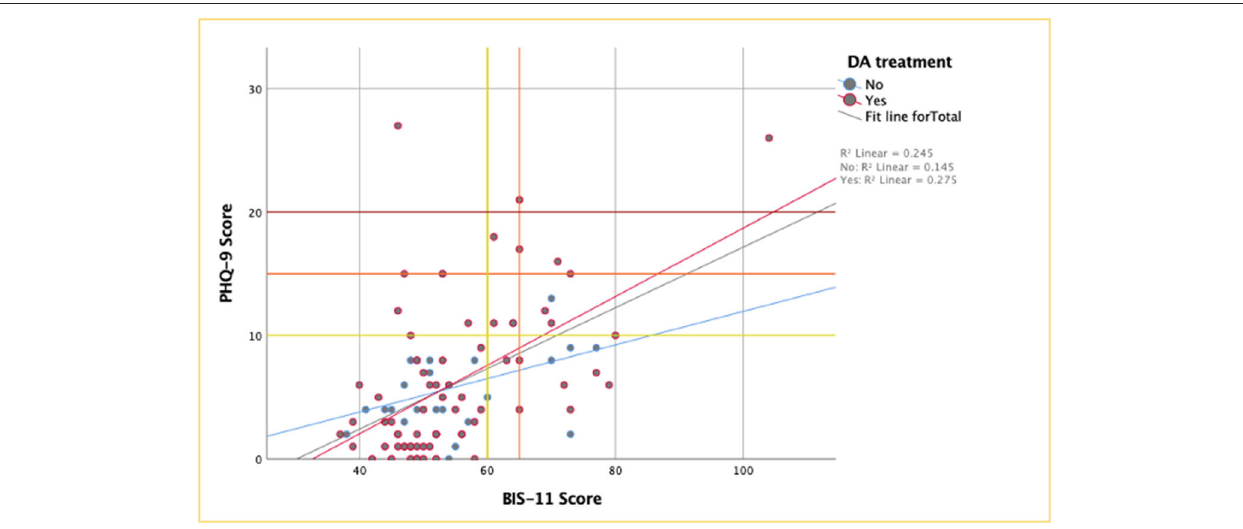
FIGURE 1 | PHQ-9 by BIS-11 scores. Survey scores in patients treated with DA had a moderate correlation, reaching statistical significance, while correlation was mild and NS in the not treated group. Y-axis threshold lines: moderate (yellow), moderately severe (orange) and severe (red) depression by PHQ-9; X-axis reference lines: threshold for ICD patients with PRLs (yellow) & patients with gambling disorders (orange) by BIS-11.